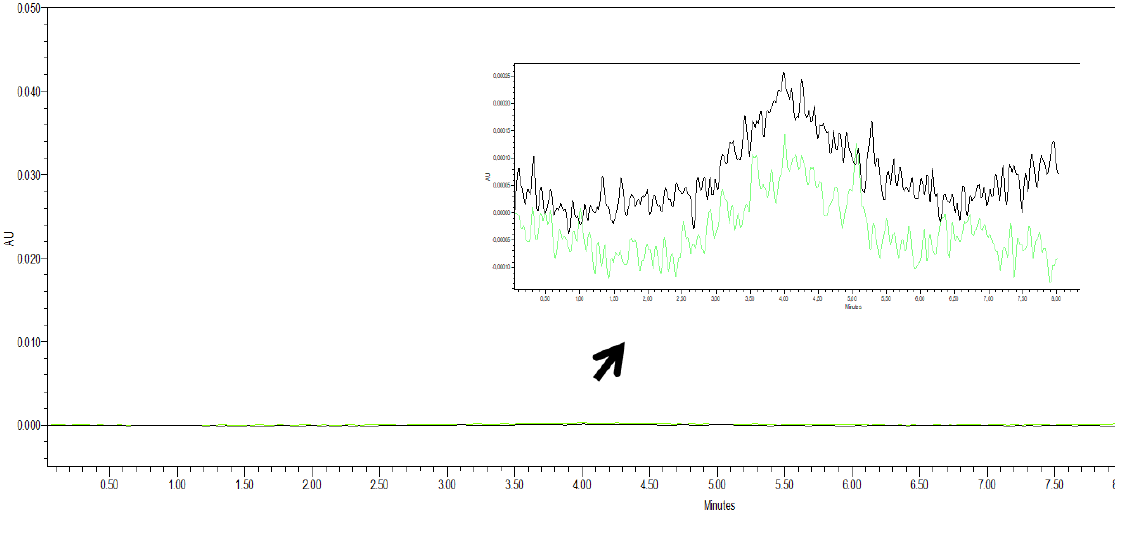
Figure 3. Chromatograms of polyphosphate ester-type transporters: P4 and P6. * Note: P4 (green), P6 (black).